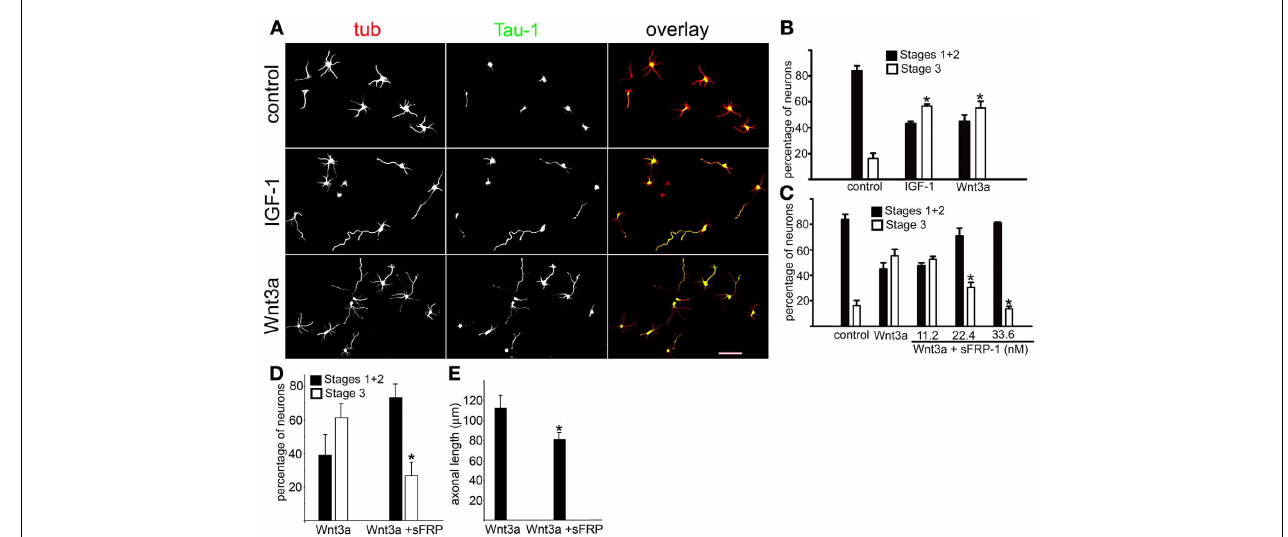
FIGURE 1 | Wnt3a triggered hippocampal neuron polarization. (A) Double immunofluorescence micrographs of hippocampal neurons after 20h in culture showing the distribution of the neuronal marker β -III tubulin (tub) and the axonal marker Tau-1. Cells were cultured in control medium (5nM insulin, top) or in medium containing either 20nM IGF-1 (middle) or 1.35nM Wnt3a (bottom). (B) Percentage ( ± sem) of neurons at different stages of differentiation grown for 20h in control medium or in the presence of either 20nM IGF-1 or 1.35nM Wnt3a ( n = 3 independent experiments). At least 100 cells were scored for each condition. ∗ p < 0 . 005 compared to control. (C) Percentage ( ± sem) of neurons at different stages of differentiation grown in control medium or in the presence of 1.35nM Wnt3a or 1.35nM Wnt3a plus different concentrations of sFRP-1. Note the significant